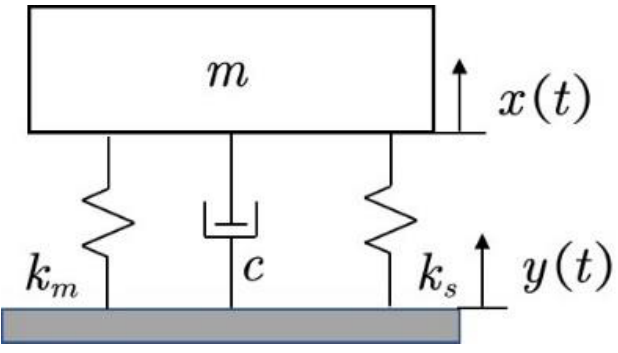
Figure 7. Diagrammatic sketch of PECVIS.